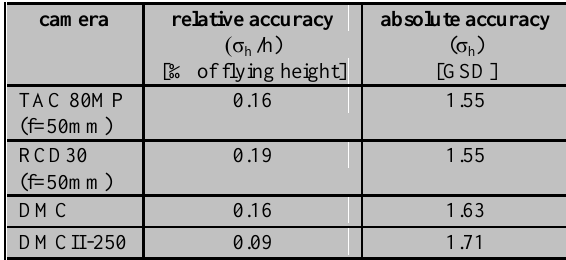
Table 3. Elevation accuracy of digital aerial frame cameras at 60% forward overlap and parallax accuracy of σ px’ =0.5 pixels